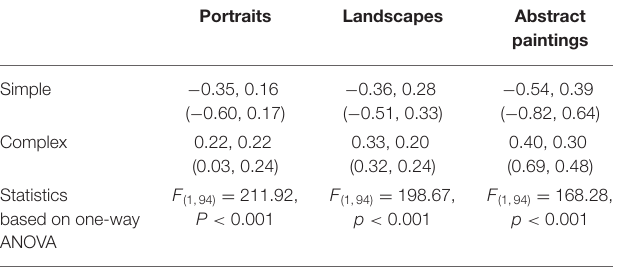
TABLE 2 | The mean complexity Z-scores and SD (raw scores, SD) in the six conditions and statistically significant differences between simple and complex groups of images within each category of painting content.